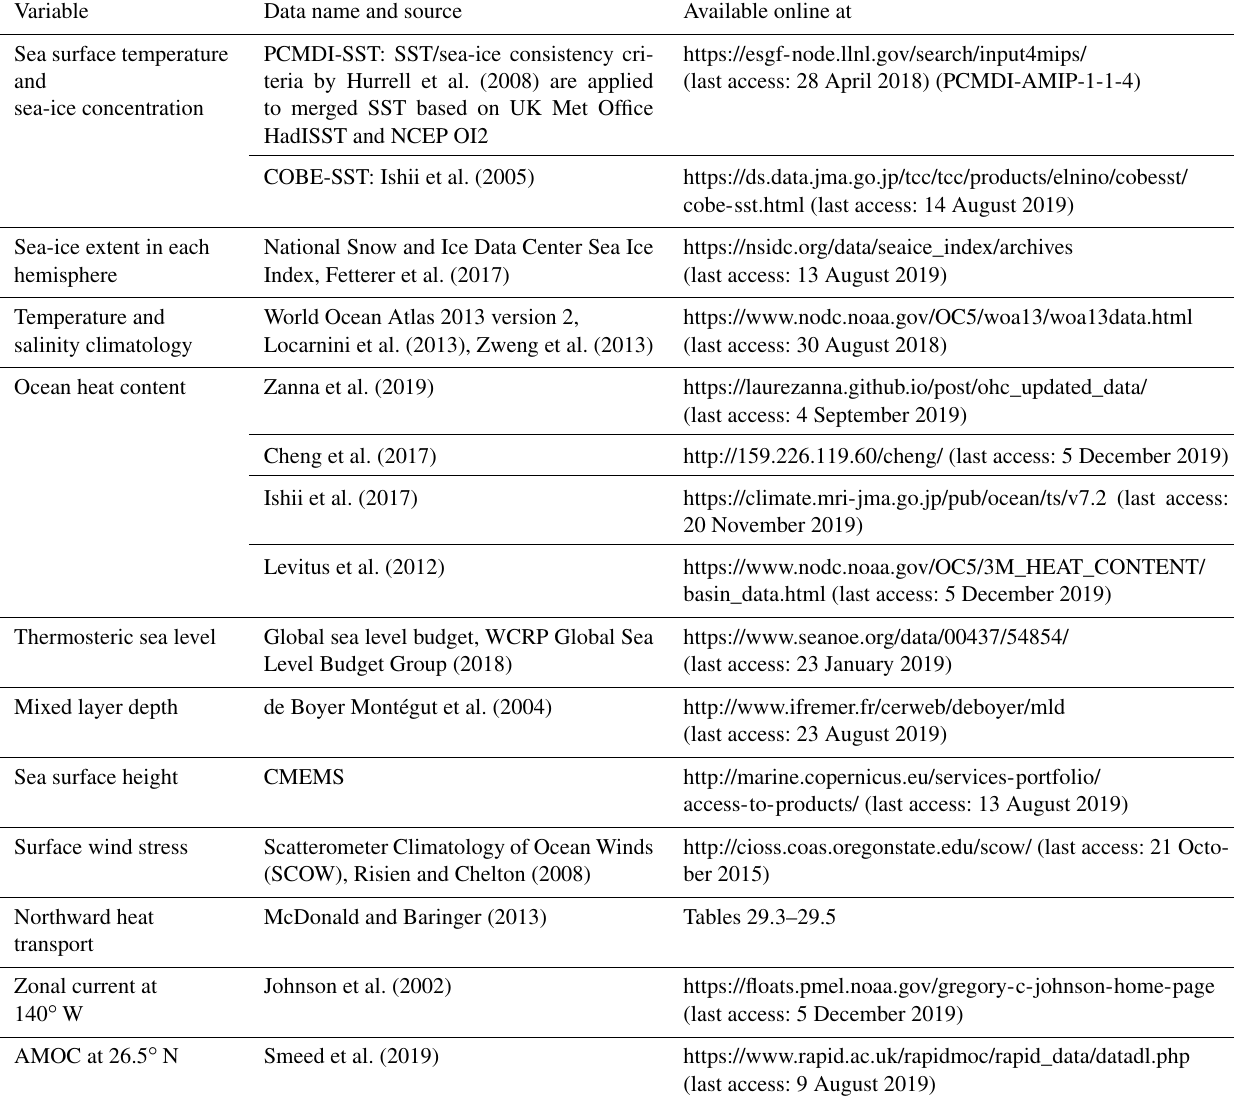
Table C1. Observational data used to evaluate